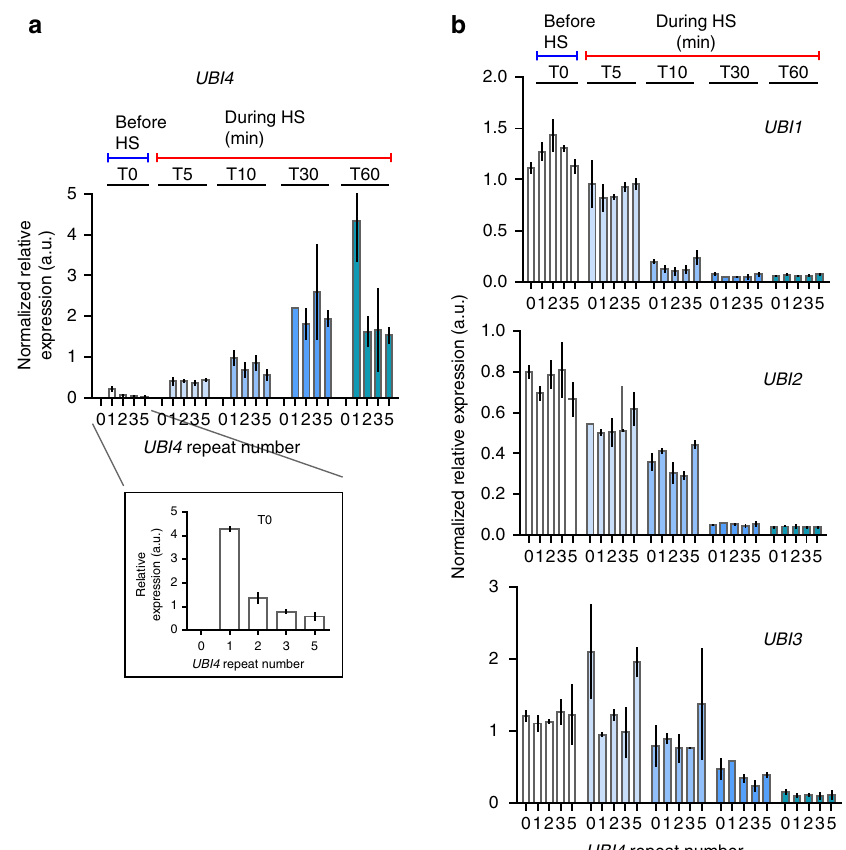
Fig. 3 Time course of expression of all ubiquitin-coding genes in the UBI4 repeat variants during heat shock. a Time series of UBI4 expression in the repeat variants (carrying a UBI4 gene encoding either 0, 1, 2, 3, or 5 ubiquitin units) during a sustained heat shock (HS) at 44 °C. UBI4 transcripts were measured by real-time quantitative PCR (RT-qPCR) using primers that speci fi cally anneal to one ubiquitin moiety allowing the measurement of the transcripts from each UBI4 repeat variant rather than the total number of ubiquitin moieties per transcript. Inset shows the expression of UBI4 at time point 0 (before HS) in the repeat variants. b Time series of UBI1 , UBI2 , and UBI3 expression in the UBI4 repeat variants during the HS at 44 °C. Primers speci fi c for the ribosomal protein-coding region were used to distinguish between the different genes. a , b Data are mean of 2 biological replicates (and 2 technical replicates per sample) ± calculating the frequency of the remaining fl uorescent cells over the total number of cells at multiple time points during the HS (Fig. 4a and Methods for details). Whereas Ub G76V -GFP was degraded with a half-life of ~ 2 h in cells containing a 5-repeat UBI4 during HS, its half-life gradually became longer with decreasing UBI4 repeat number (Fig. 4b). In contrast, the levels of the stable form of GFP (Ub-M-GFP) were the same for all strains and were relatively unchanged throughout the course of the HS (Fig. 4b, lower panel ).